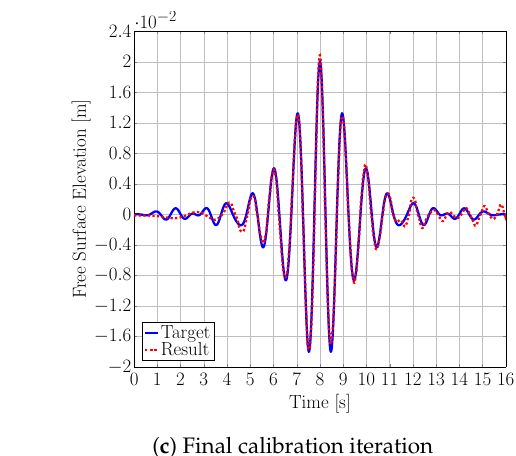
λ p and length 1 4 4